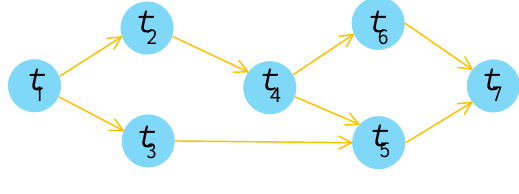
Figure 1. DAG model of a workflow with seven